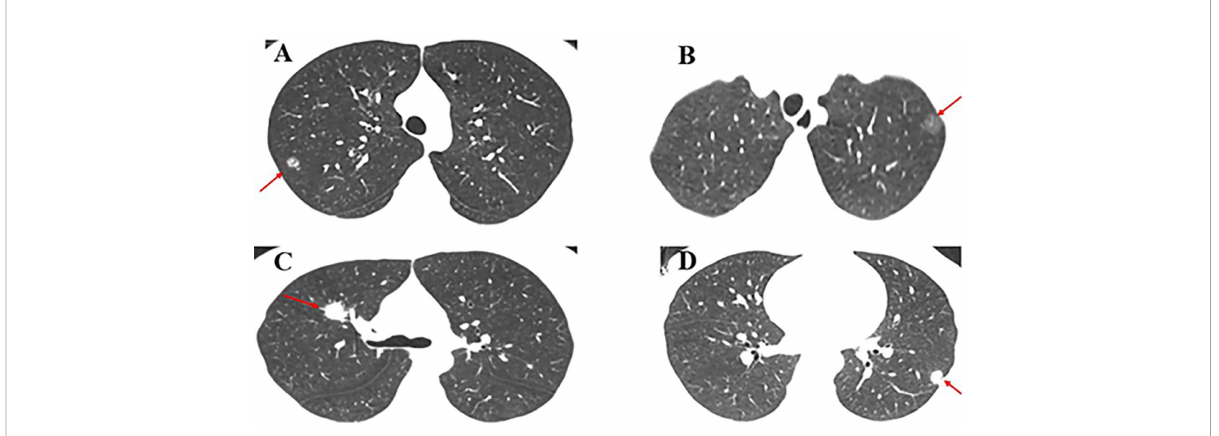
FIGURE 1 Case presentation. (A) A 15-year-old male patient with mGGO (9 mm) in the posterior segment of the right upper lobe underwent single-port VATS segmentectomy. The fi nal pathology was AIS; (B) A 17-year-old female patient with pGGO (10 mm) in the posterior segment of the left upper lobe underwent single-port VATS segmentectomy. The fi nal pathology was MIA; (C) A 28-year-old female patient with SN (18 mm) in the right upper lobe underwent single-port VATS lobectomy. The fi nal pathology was invasive mucinous adenocarcinoma; (D) A 35-year-old female patient with SN (12 mm) in the left lower lobe underwent single-port VATS lobectomy. The fi nal pathology was lepidic predominant